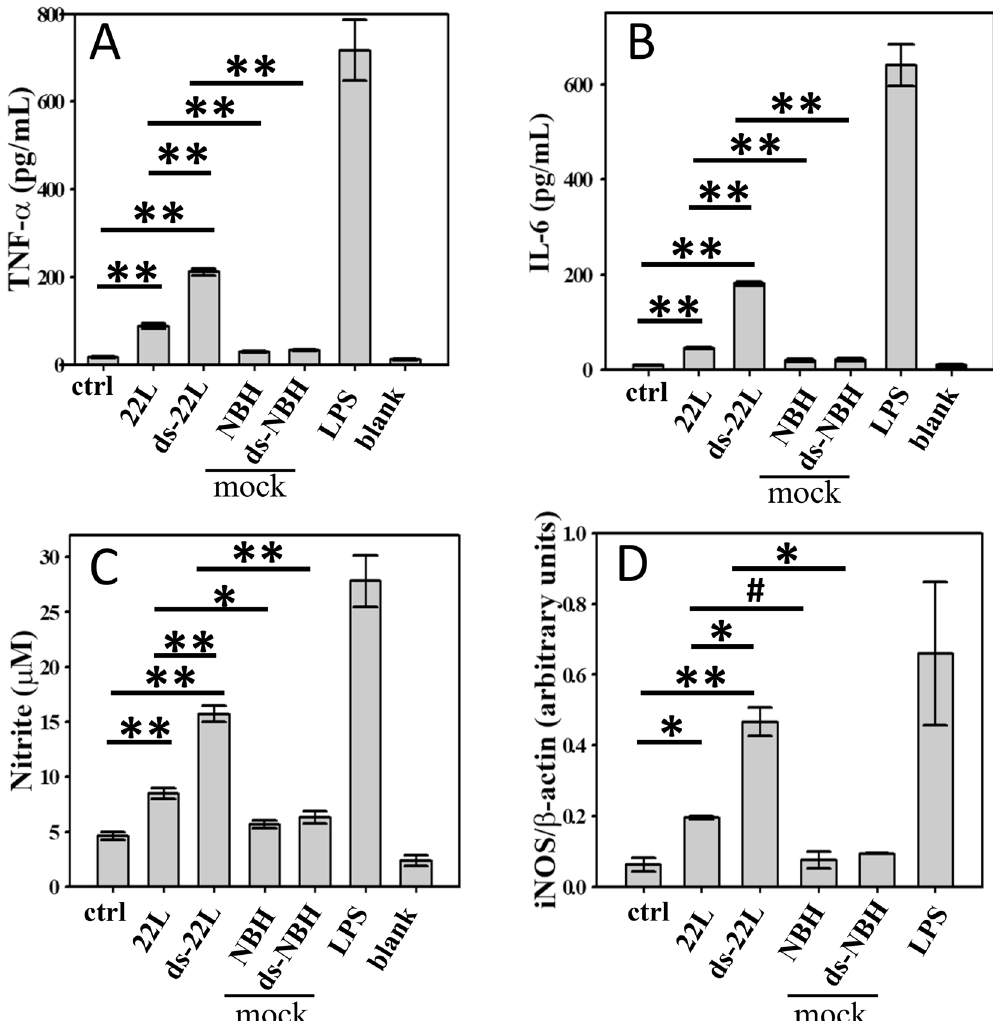
Figure 7. Analysis of PrP Sc -induced proinflammatory responses in primary microglia. Amounts of TNF α ( A ) IL6 ( B ) NO ( C ) and the expression levels of iNOS ( D ) measured upon incubation of primary microglia with purified, brain-derived 22L or ds-22L PrP Sc for 18 hours. As negative controls, cells were treated with mock-purified NBH or ds-NBH, or cultured in the absence of treatment (ctrl). As a positive control, cells were treated with LPS (100 ng/ml). The final concentrations of 22L or ds-22L PrP Sc in the cell culture media were equivalent to the amounts of PrP Sc in 0.75% 22L scrapie brain homogenate. Western blots probed with anti- β actin antibody served as protein loading control for analysis of expression levels of iNOS in panel D. All experiments were performed three times, and the data are presented as the mean ± SD. Statistical significance (P) were calculated by Student’s t-test and indicated as * and ** for P < 0.05 and P < 0.005, respectively, and # for insignificant (P > 0.05)